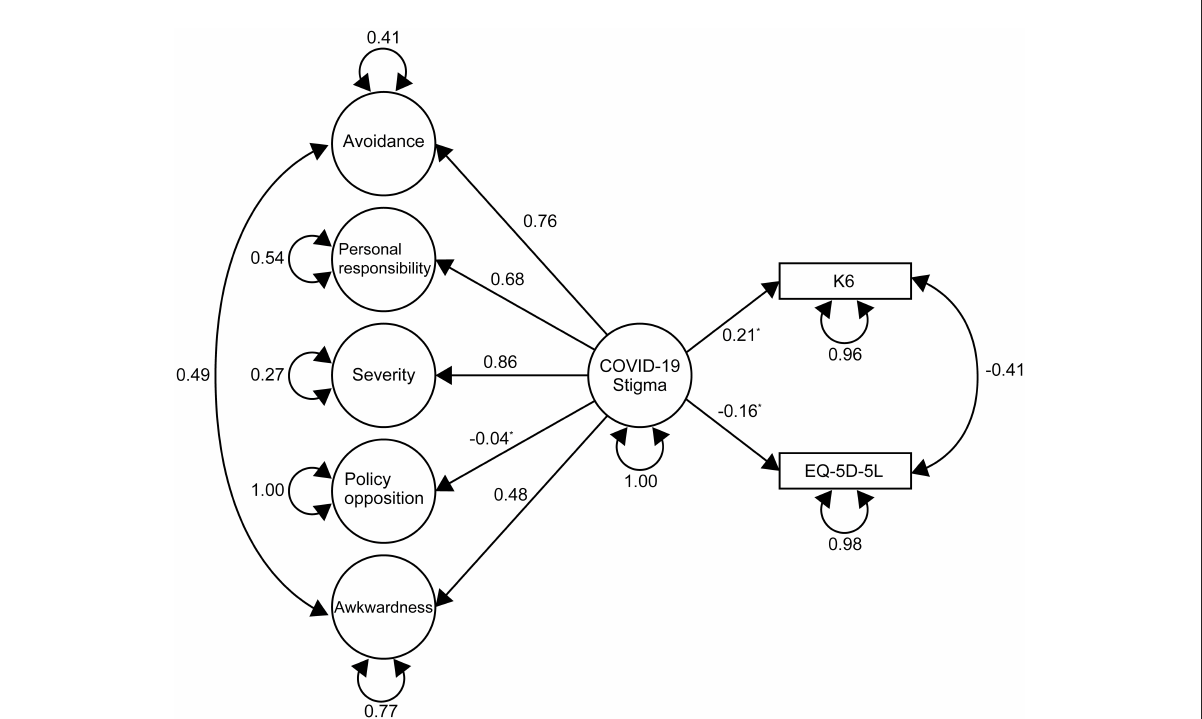
FIGURE2 Path diagram and results of the structural equation modeling. Values next to each path indicate the standardized estimates. The double-headed curved arrows indicate the correlation of residual errors between the variables. The circular curved arrows represent the variance of error. Standardized Root Mean of the Residual = 0.055, Comparative fit index = 0.956, Tucker–Lewis Index = 0.951, Root Mean Square Error of Approximation = 0.053. *The p -values were < 0.0001 for all estimates except for Policy Opposition ( P = 0.593), EQ-5D-5L ( P = 0.023), and K6 ( P = 0.002). COVID-19 stigma; social stigma related to the coronavirus disease, K6; 6-item Kessler Psychological Distress Scale, EQ-5D-5L; EuroQoL 5- Dimension 5-Level. COVID-19 stigma scale scores for each factor according to each characteristic subgroup. The values